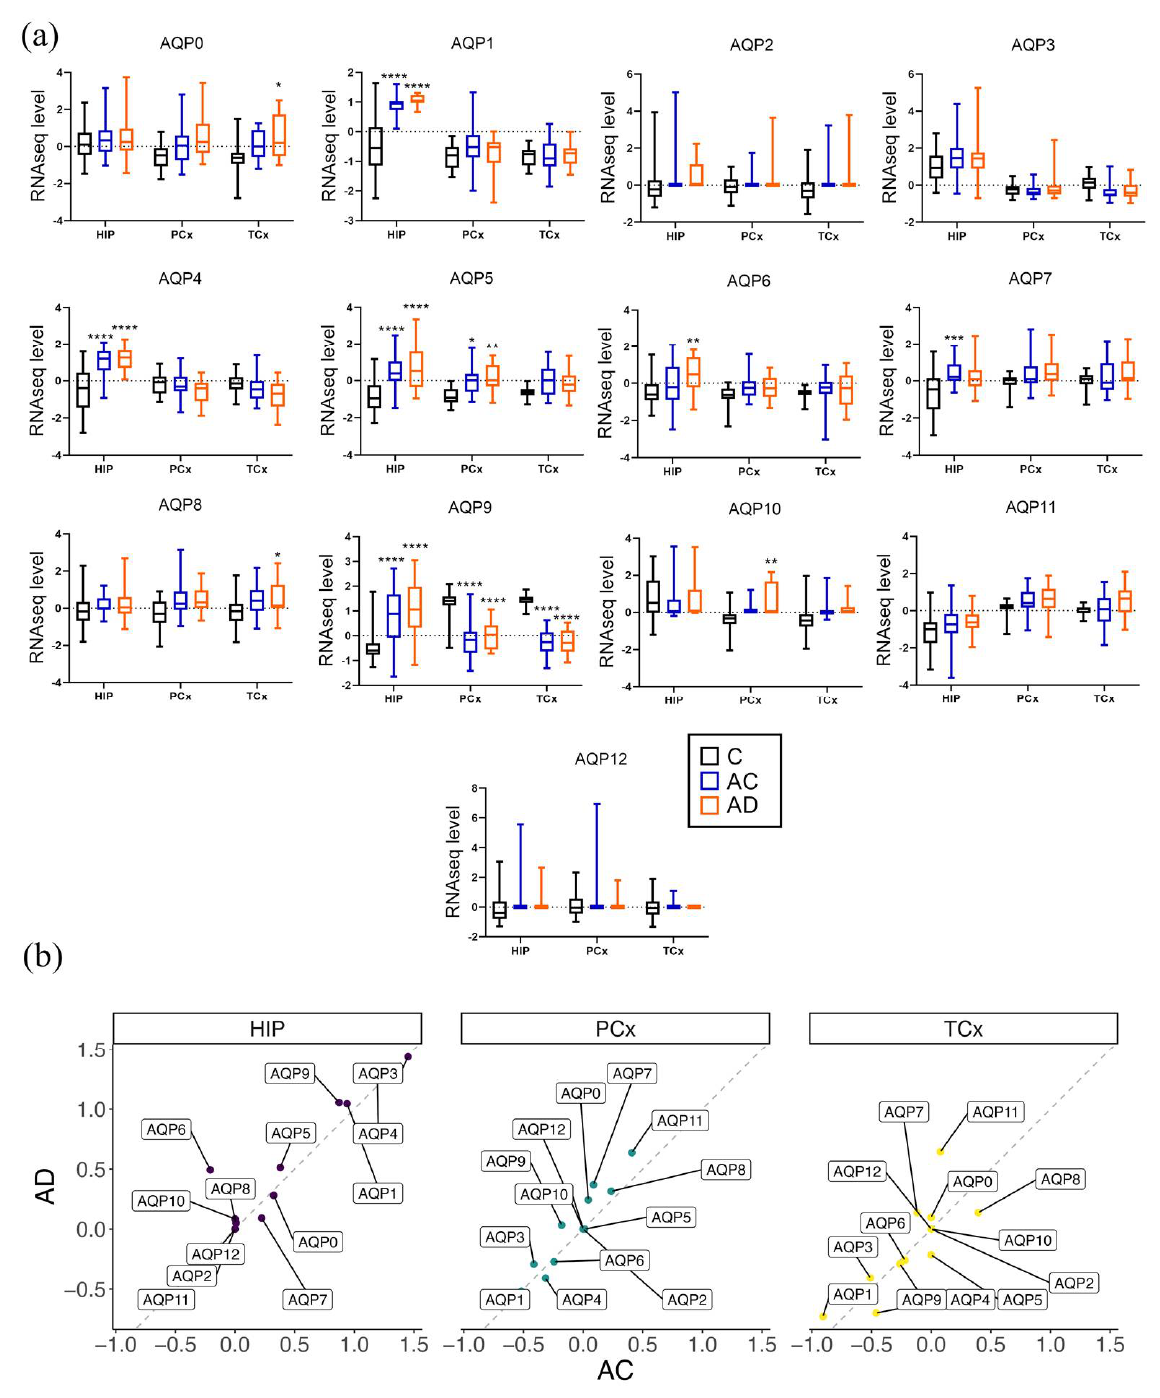
Figure 4. Associations between AD status and AQP transcript levels in the human brain. ( a ) Results of multiple comparison analyses of AQP RNAseq levels in the three groups, young control group (C), age control group (AC) and the AD group, are represented as box and whisker plots showing median, min and max values. Statistical comparisons for AD were carried out with reference to the (C) and (AC) groups, showing **** for p < 0.0001, *** for p < 0.001, ** for p < 0.01 and * for p < 0.05. ( b ) The average trend comparison plot of AQP expression profiles in the AC vs. AD groups. Each point represents the average logFC mean expression for each gene and region, for AC vs. AD. The dotted lines represent identity (y = x) in the average transcript levels between the AC and AD groups; points above the line are higher in AD and points below are higher in the AC groups.